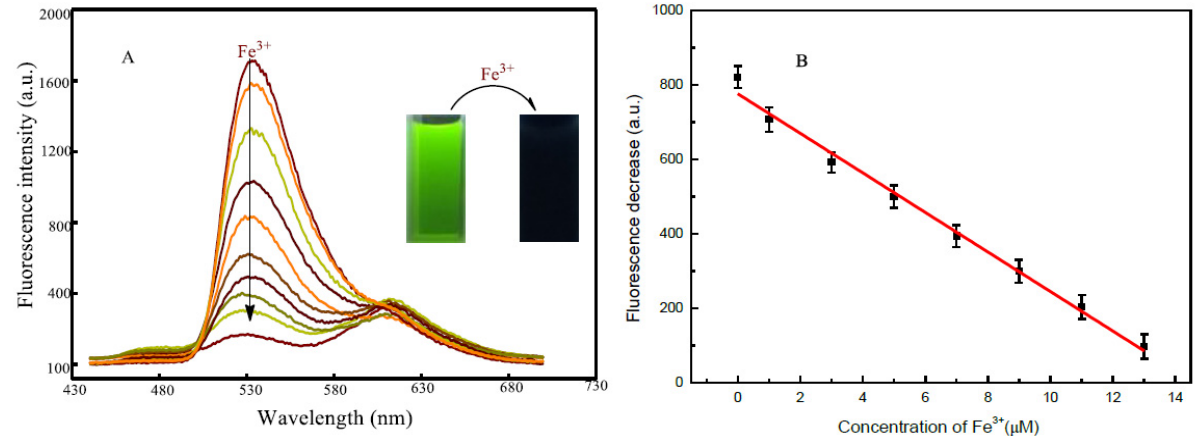
Figure 5. ( A ) Fluorescence spectra of 2-ACP in the presence of different concentrations of Fe 3+ , including 0, 1, 3, 5, 7, 9, 11 and 13 µ M (from top to bottom) with excitation at 345 nm; ( B ) The fluorescence intensity change of 2-ACP as a function of Fe 3+ concentrations. Table 2. Analytical results of Fe 3+ in real samples using 2-APC as a probe.